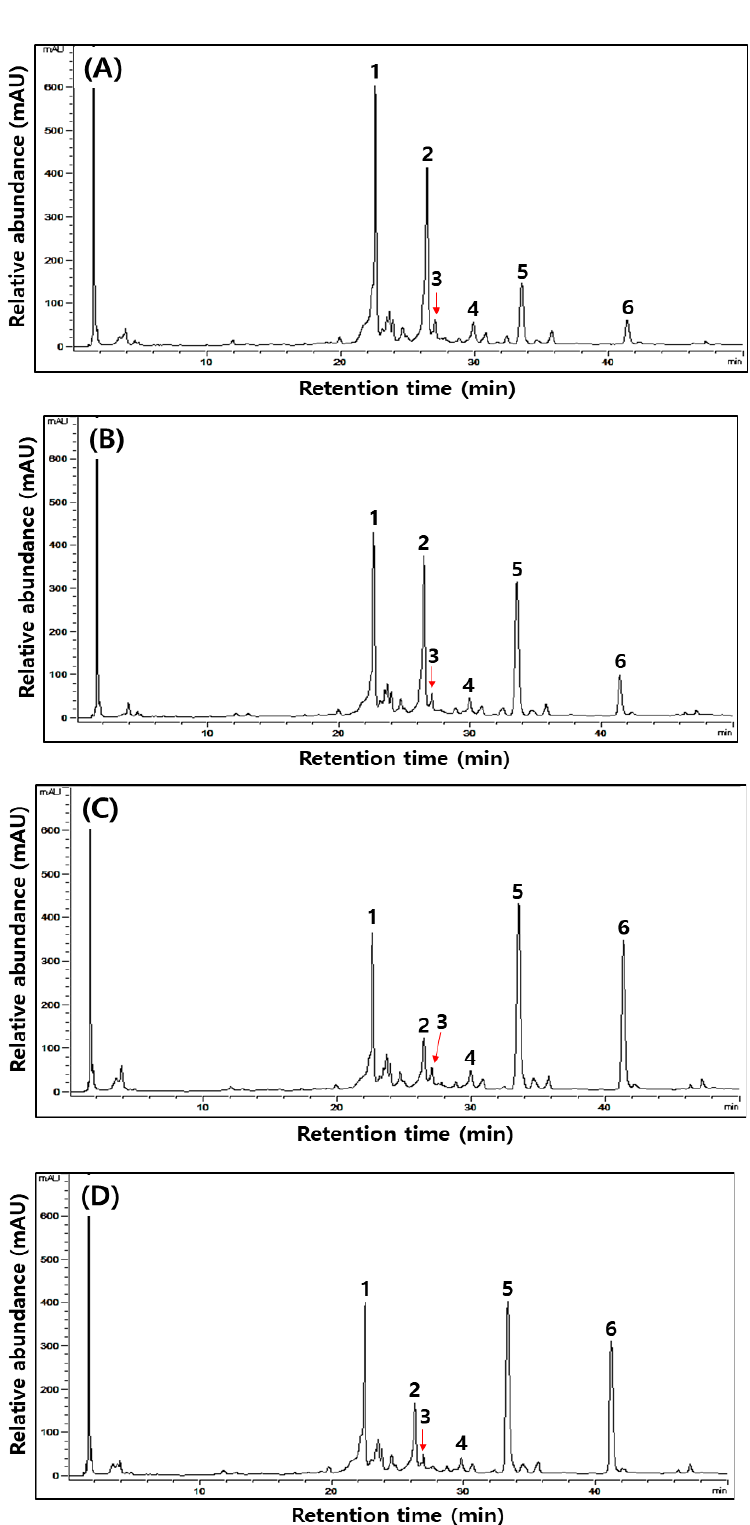
Figure 1. Typical HPLC chromatograms of isoflavones during the fermentation of isoflavone-enriched soybean leaves (IESLs) with the use of Lactiplantibacillus plantarum P1201 and/or Levilactobacillus brevis BMK184 as starters. Samples: The IESLs were fermented at 35 °C for 72 h, with the use of Lactiplantibacillus plantarum P1201 and/or Levilactobacillus brevis BMK184 as starters. ( A ) 0 h, ( B ) P1201 for 72 h, ( C ) BMK for 72 h, and ( D ) P1201 and BMK184 for 72 h. Chromatogram: 1, daidzin; 2, genistin; 3, malonyldidzin; 4, malonylgenistin; 5, dadzein; 6, genistein. Table 4. Changes of isoflavone contents during the fermentation of isoflavone-enriched soybean leaves (IESLs) with the use of Lactiplantibacillus plantarum P1201 and/or Levilactobacillus brevis BMK184 as starters.